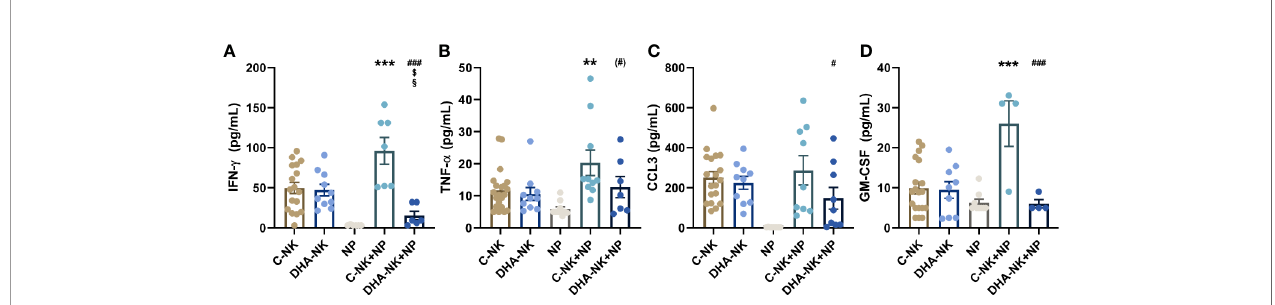
FIGURE 6 | The effects of neutrophils on production of IFN- g (A) , TNF- a (B) , CCL3 (C) , and GM-CSF (D) in co-cultures with NK cells pre-incubated with DHA or not. NK cells were pre-incubated for 18 h in the absence (C-NK) or presence (DHA-NK) of 50 µM docosahexaenoic acid and then stimulated with IL-2 (2 ng/ml), IL- 12 (2 ng/ml), and IL-15 (10 ng/ml) and cultured with or without neutrophils for further 18 h (C-NK+NP and DHA-NK+NP). Neutrophils were also cultured alone for 18 h (NP). Cytokine concentrations were determined by ELISA and are presented as pg/ml. Data are presented as means ± SEM; * indicates difference between C-NK+NP and C-NK, § difference between DHA-NK and DHA-NK+NP, $ difference between DHA-NK+NP and C-NK, and # difference between DHA-NK+NP and C-NK+NP. One symbol indicates p < 0.05, two symbols p < 0.01, and three symbols p < 0.001. Symbol in parenthesis indicates p = 0.05 – 0.1. One outlier was removed in the NP group in A and B, one outlier was removed in the C-NK+NP group in B and D and one outlier was removed in the DHA-NK+NP group in A. n = 4 – 21 (independent donors), collected in at least three independent experiments. In Supplementary Figure 3 all outliers are